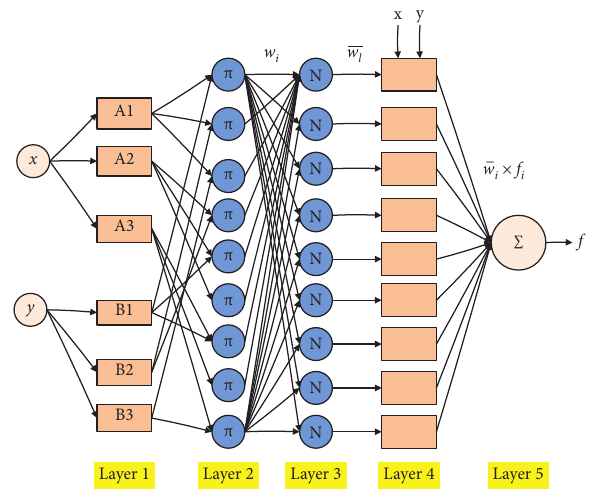
Figure 1: ANFIS architecture of two inputs and one output with four